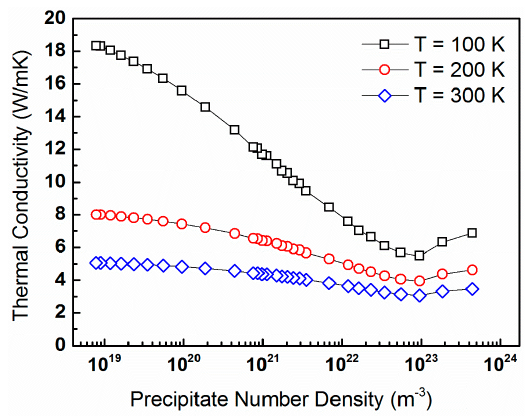
Figure 7. The lattice thermal conductivity of PbTe calculated from expression (16) as a function of the precipitate number density for v f held constant at 5% and ∆ R = 1 nm, for T = 100 (black squares), 200 (red circles), and 300 K (blue diamonds).